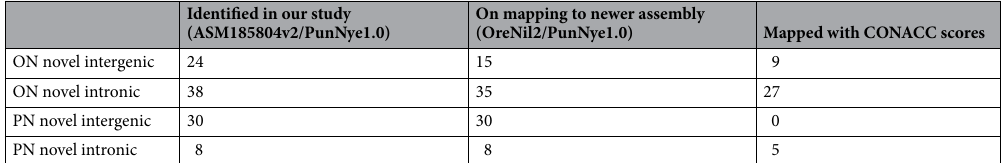
Table 2. Number of novel transcripts that were mapped between the ON’s two assembly versions and later with CONACC scores.